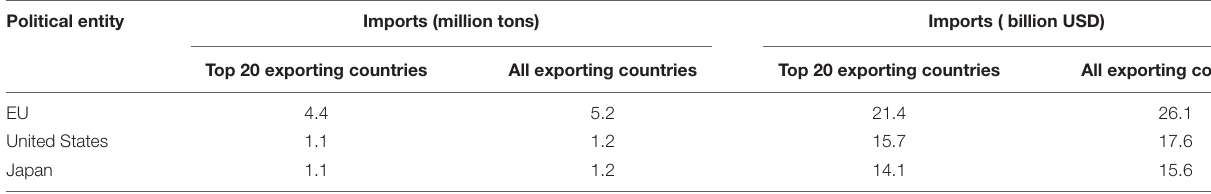
TABLE 1 | Fish exports to the EU, the United States and Japan.